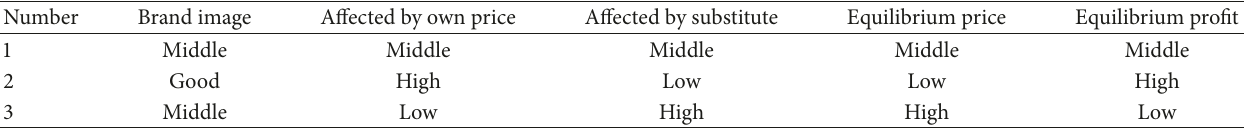
Table 5: The comparison of the three tobacco